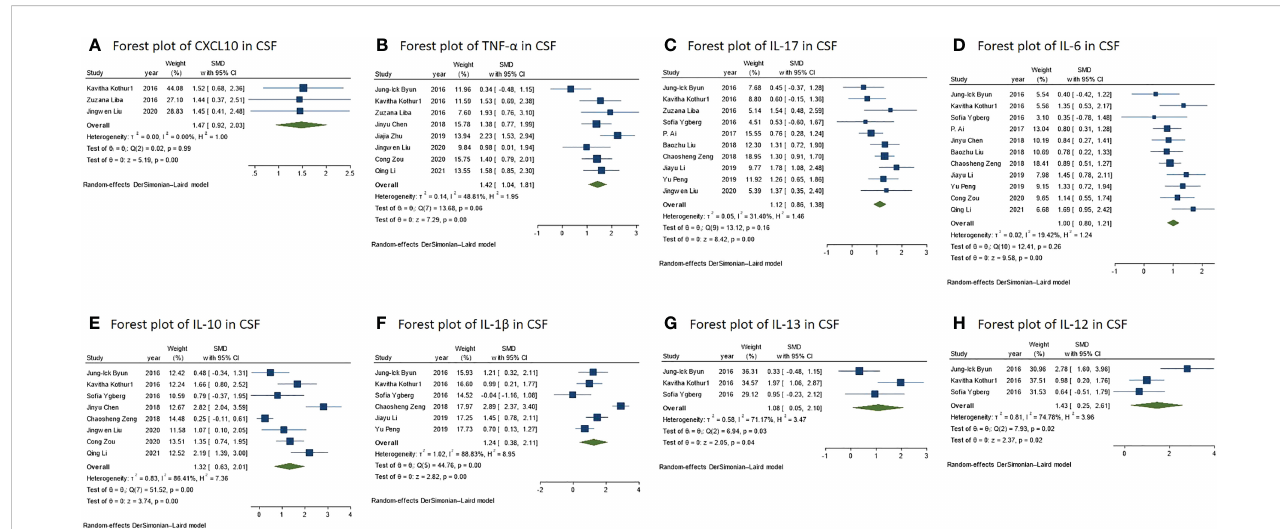
FIGURE 3 (A) Forest plot for the meta-analysis of the CXCL10 level in the CSF of NMDAR-E vs. control. (B) Forest plot for the meta-analysis of the TNF- a level in the CSF of NMDAR-E vs. control. (C) Forest plot for the meta-analysis of the IL-17 level in the CSF of NMDAR-E vs. control. (D) Forest plot for the meta- analysis of the IL-12 level in the CSF of NMDAR-E vs. control. (E) Forest plot for the meta-analysis of the IL-10 level in the CSF of NMDAR-E vs. control. (F) Forest plot for the meta-analysis of the IL-1 b level in the CSF of NMDAR-E vs. control. (G) Forest plot for the meta-analysis of the IL-13 level in the